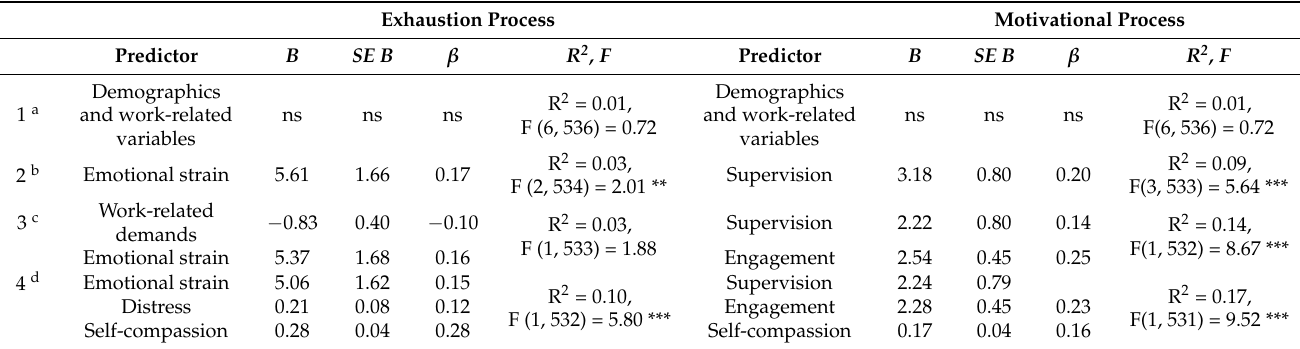
Table 4. Summary of multiple regression analysis of the added value of self-compassion on compassion towards